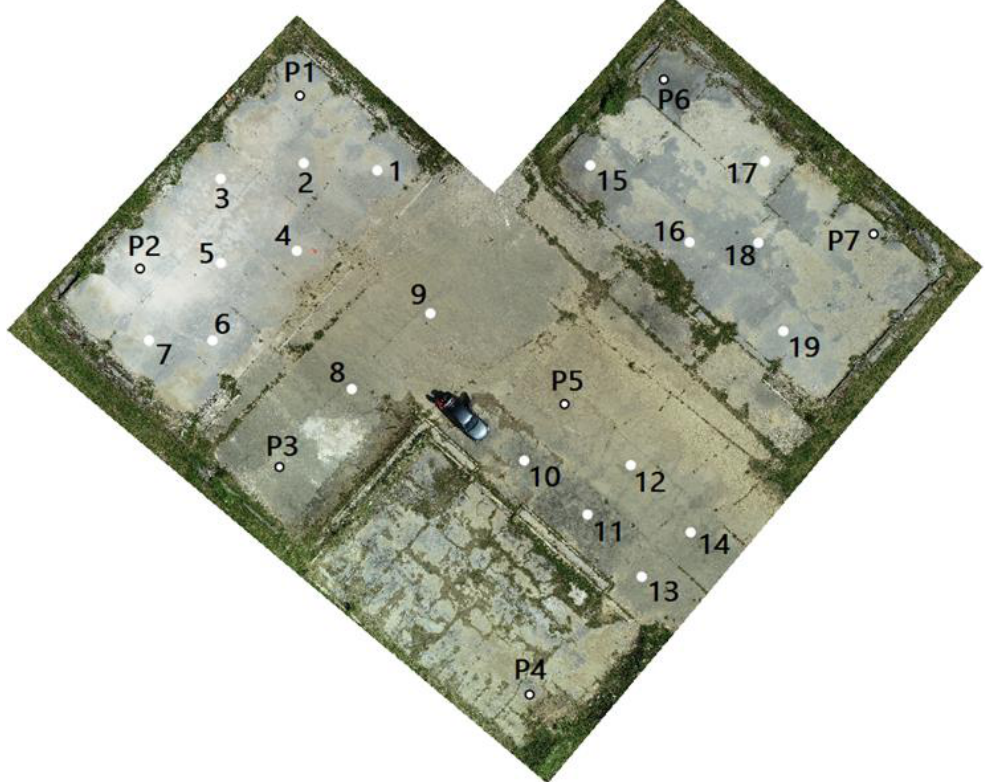
Figure 1. Established research site in the city of Samobor, Croatia, with marked GCPs (P1 – P7) and CPs (1 – 19).